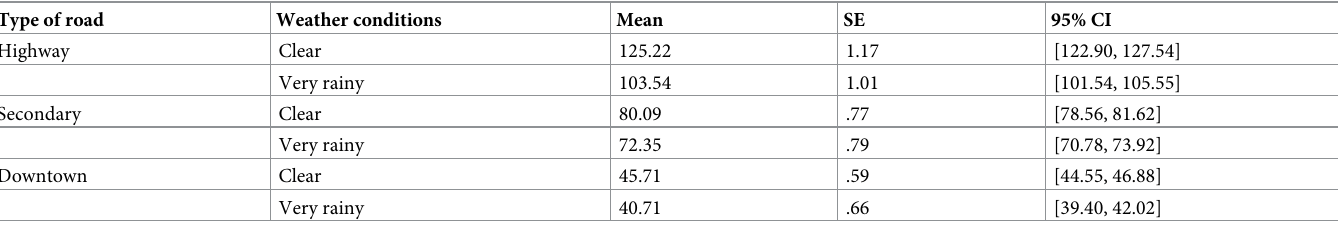
Note . SE = standard error; CI = confidence interval.